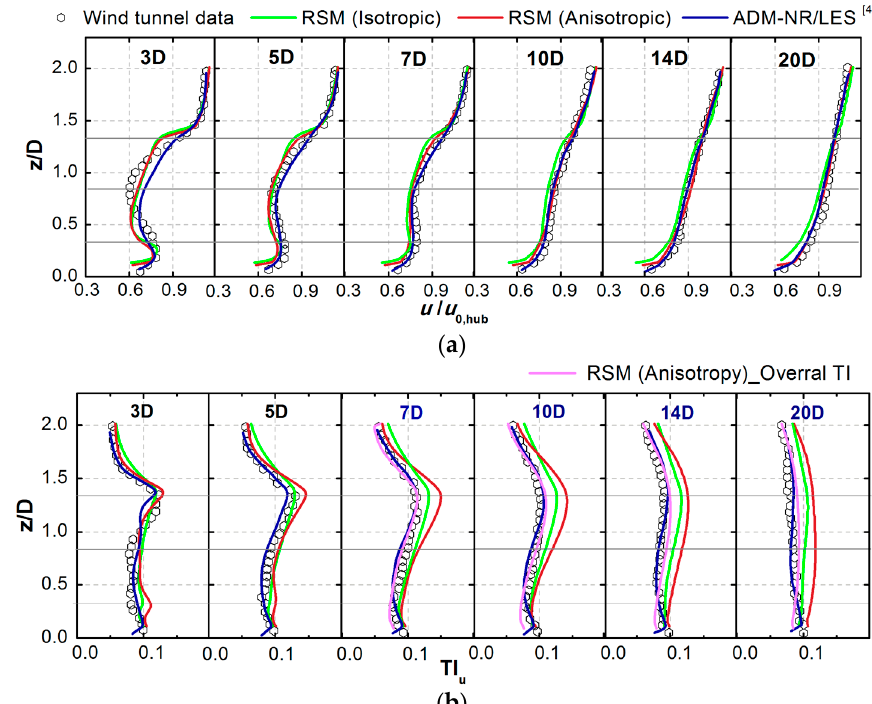
Figure 2. Comparison of simulated and measured vertical profiles of ( a ) normalized stream-wise velocity and ( b ) stream-wise turbulence intensity ( TI u ). The panels from left to right indicate the flow quantity profiles at different downstream distances behind the turbine. The horizontal gray lines represent top tip, hub height, and bottom tip heights.